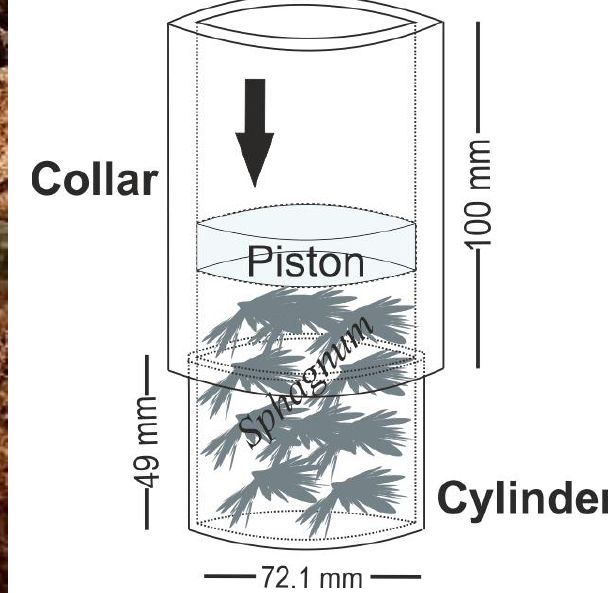
Figure 2. Cutting of the attaching fibres after driving a soil sample cylinder into a Sphagnum bale.